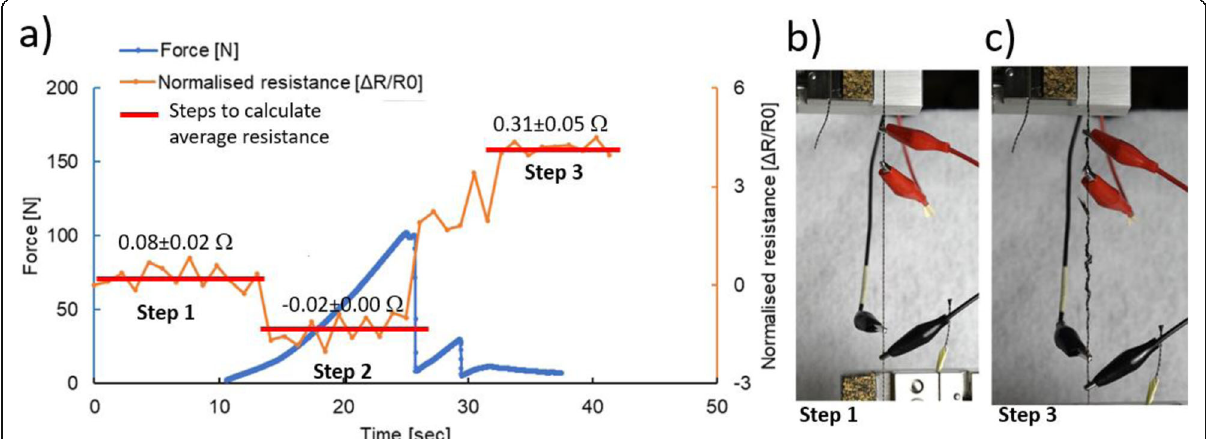
Fig. 3 a Characteristic resistance and load response of hybrid braid in tension, b - c images of the braid at initial (under tension) and final (failure) stages of